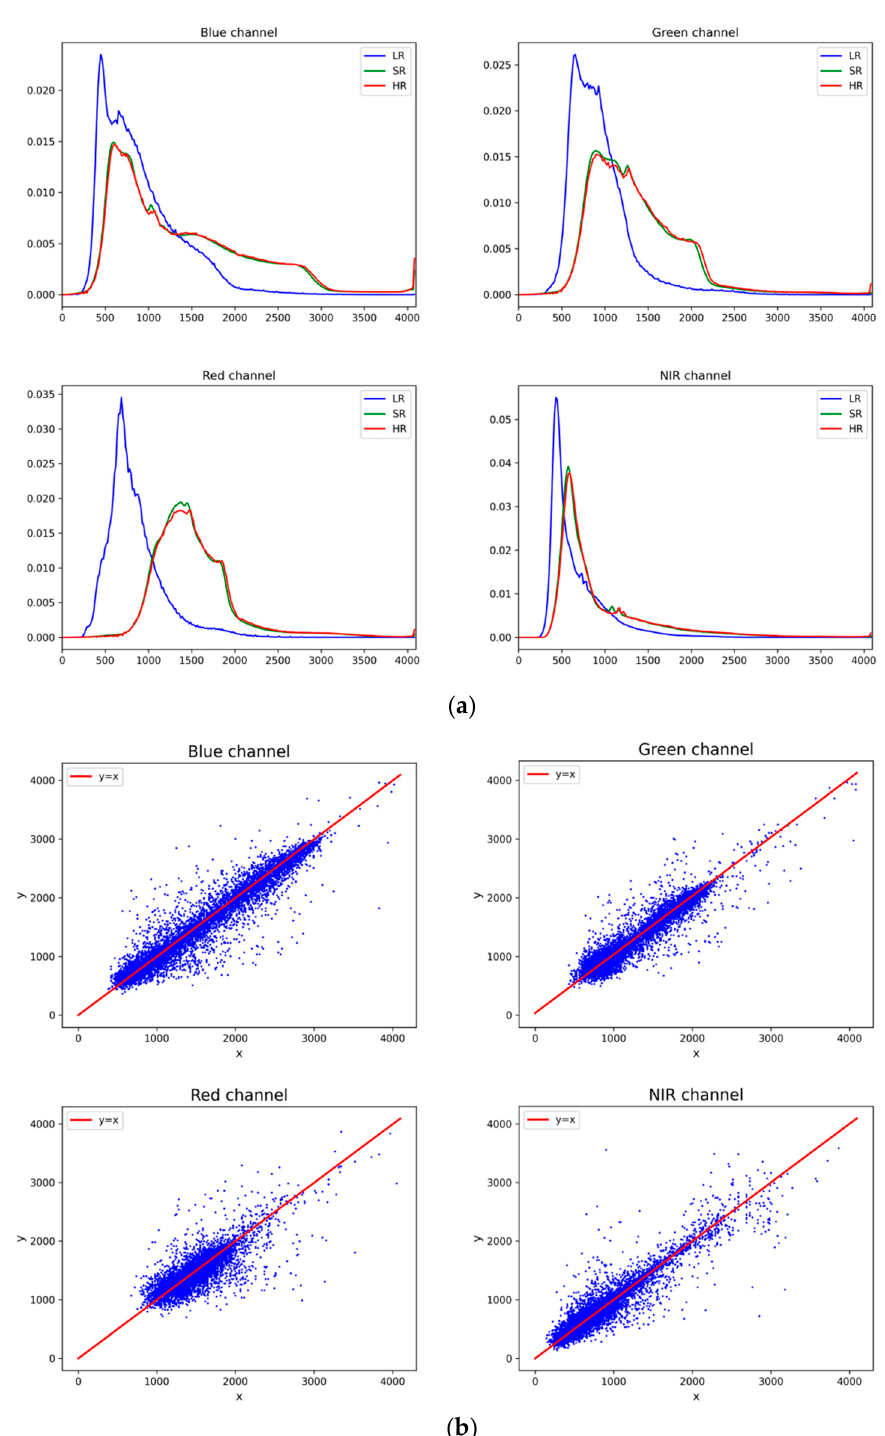
Figure 11. Validation of the preservation of the spectral properties on our dataset: ( a ) histogram of different bands of LR, HR, SR, where the X-axis represents the reflectance value and the Y-axis represents the frequency of that reflectance; ( b ) pixel reflectance values of HR, SR scatter plot of reflectance of SR. The x-axis represents the HR reflectance, and the y-axis represents the SR reflectance.